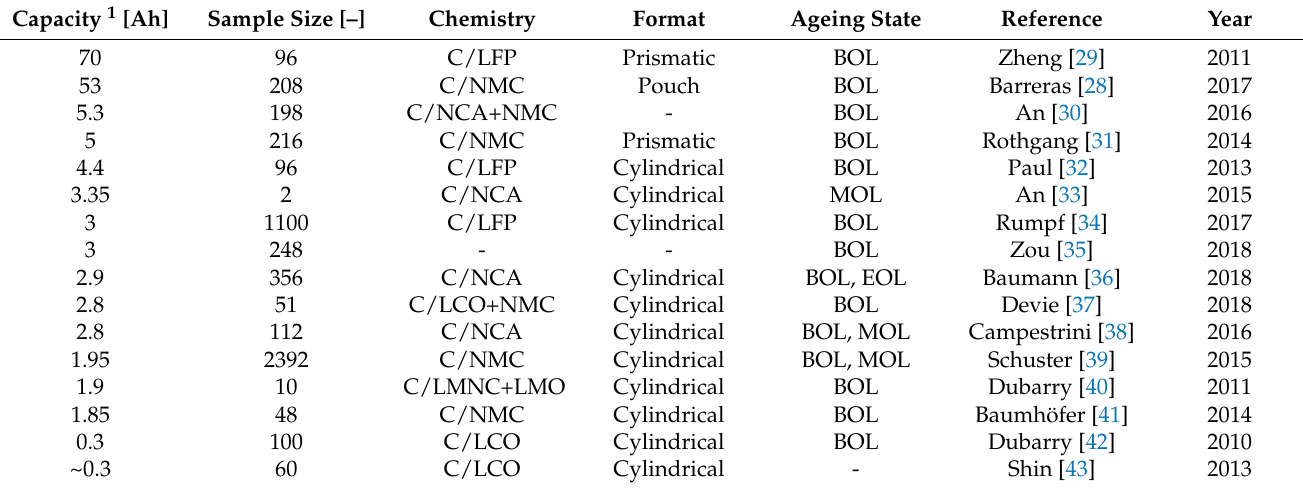
1 Articles sorted in descending order of cell capacity.